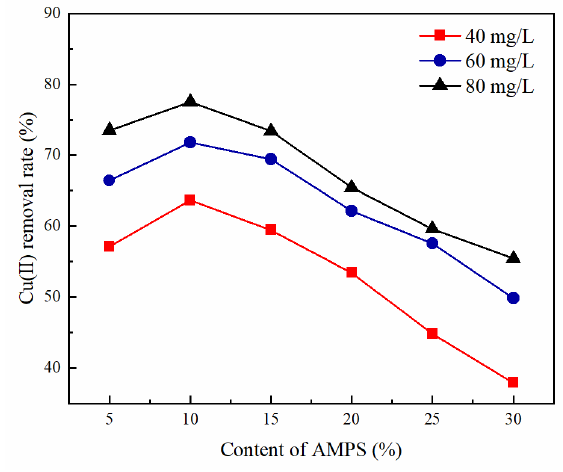
Figure 3. Effect of AMPS content on Cu(II) removal efficiency.